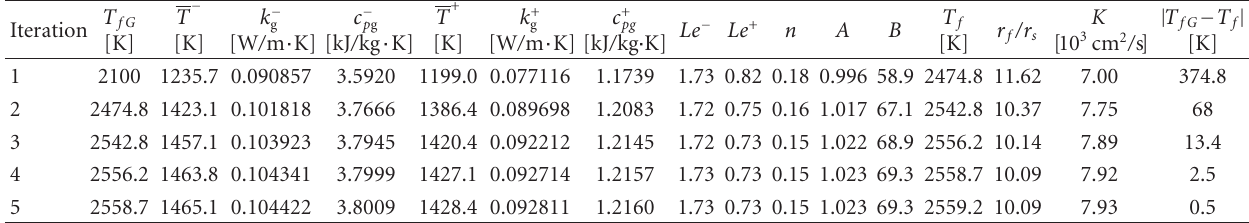
Table 2: Proposed model n -heptane results.